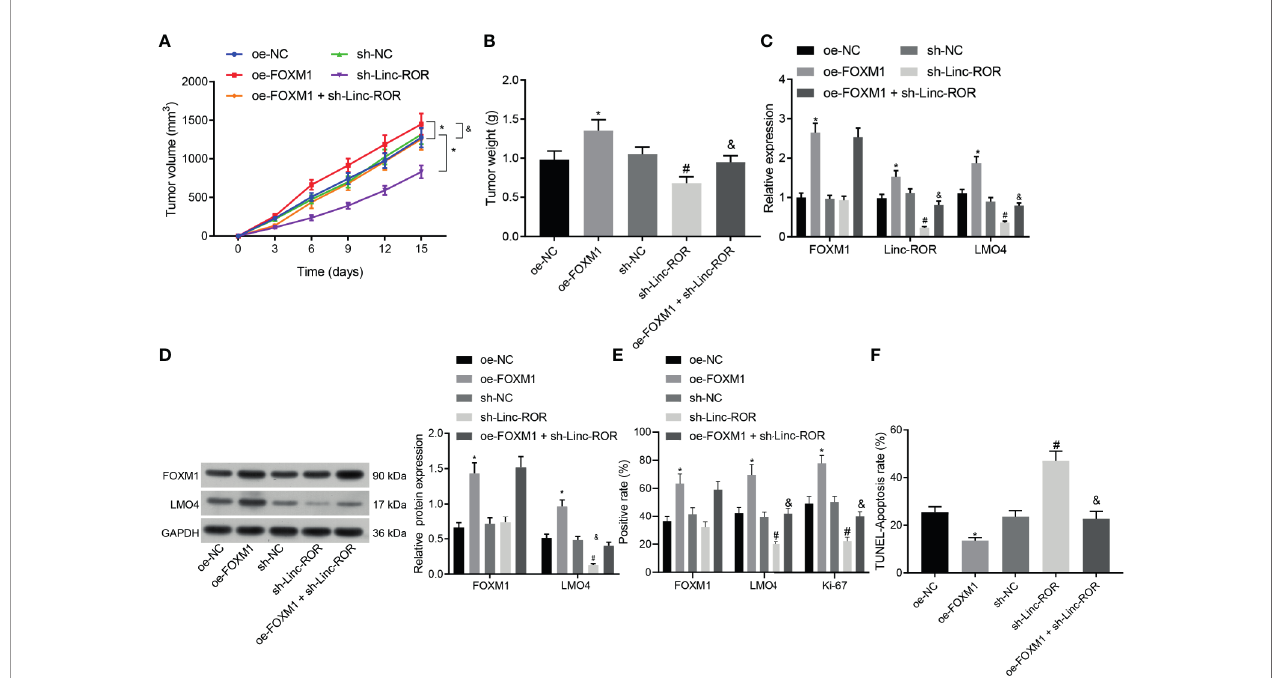
FIGURE 5 | Silencing of Linc-ROR reverses the promoting effect of overexpressing FOXM1 on tumor growth in vivo . (A) Tumor growth curve; (B) Tumor size and weight; * p < 0.05, compared with the oe-NC group, # p < 0.05, compared with the sh-NC group; (C) Expression of FOXM1, Linc-ROR, and LMO4 in mouse tumor tissues determined by RT-qPCR; * p < 0.05, compared with the oe-NC group, # p < 0.05, compared with the sh-NC group; (D) Protein expression of FOXM1 and LMO4 in mouse tumor tissues detected by Western blot; * p < 0.05, compared with the oe-NC group, # p < 0.05, compared with the sh-NC group; & p < 0.05, compared with the oe-FOXM1 group; (E) The positive expression of FOXM1, LMO4, and Ki-67 proteins in mouse tumor tissues detected by IHC; (F) The apoptosis of cells in mouse tumor tissues detected by TUNEL assay. n = 15 for mice per